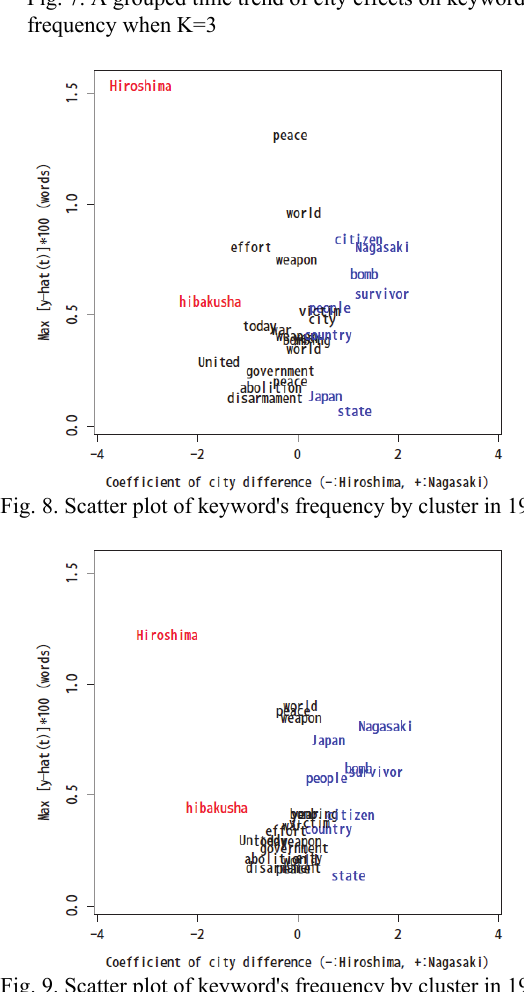
Fig. 9. Scatter plot of keyword's frequency by cluster in 1987